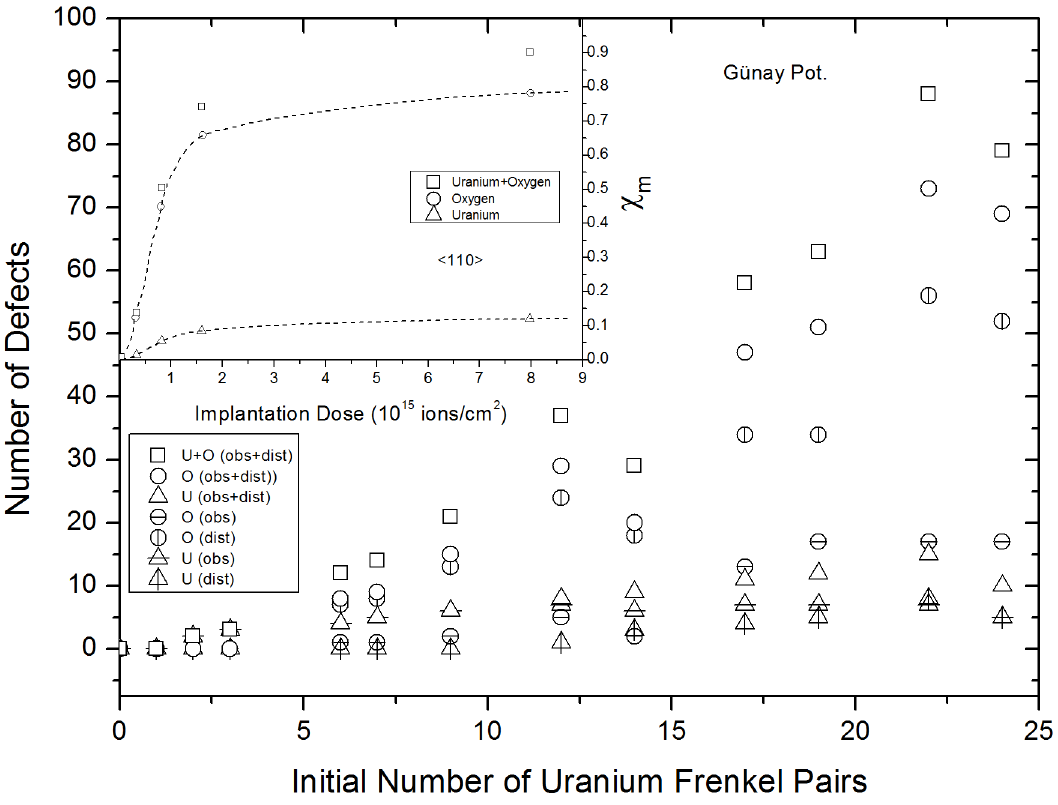
Fig 5. Günay potential results for variations in numbers of remaining and created FPs versus uranium IFPs. The inset was taken from Ref. 28 and shows the experimentally determined concentrations of uranium and oxygen FPs created, as functions of dose.